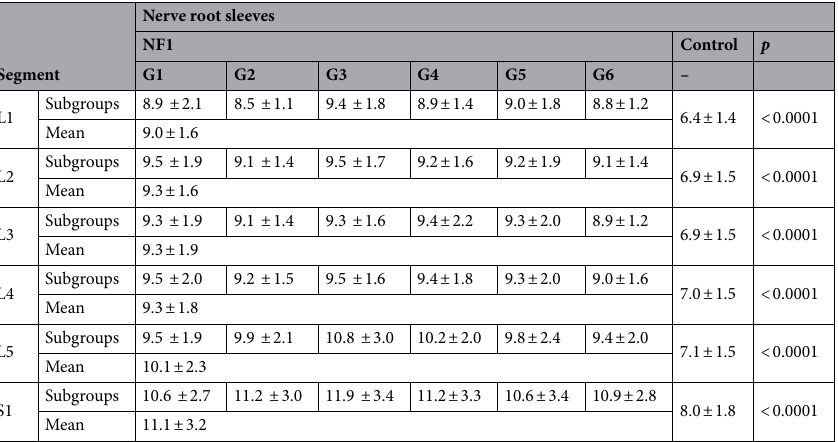
Table 2. Measurement of diameters of nerve root sleeves in NF1 patients and the control group. Values represent mean values ± standard deviation. Values are given in mm. G1: genetic subgroup 1 (type-1 deletion); G2: genetic subgroup 2 (splice mutation); G3: genetic subgroup 3 (missense); G4: genetic subgroup 4 (nonsense/frameshift mutation); G5: genetic subgroup 5 (no proof of mutation); G6: genetic subgroup 6 (no analysis